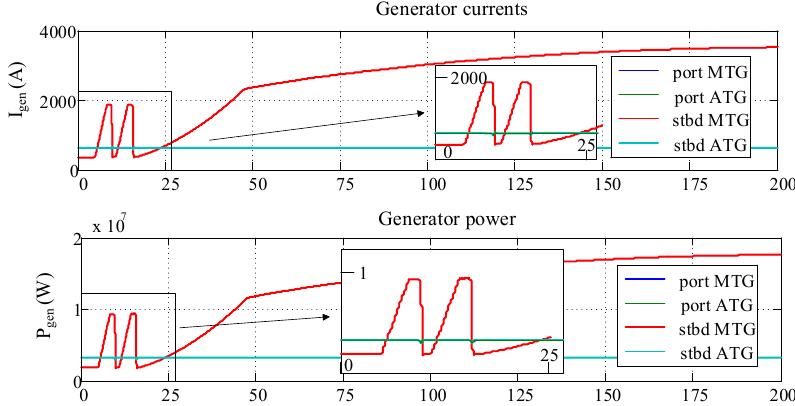
Figure 12. Case 2 generator current and power.